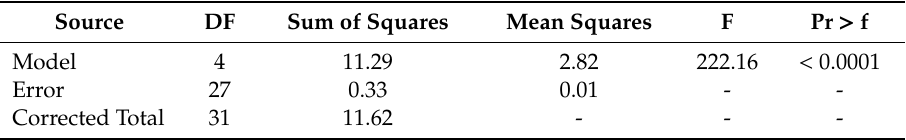
(Number of load cycles) - Log 10